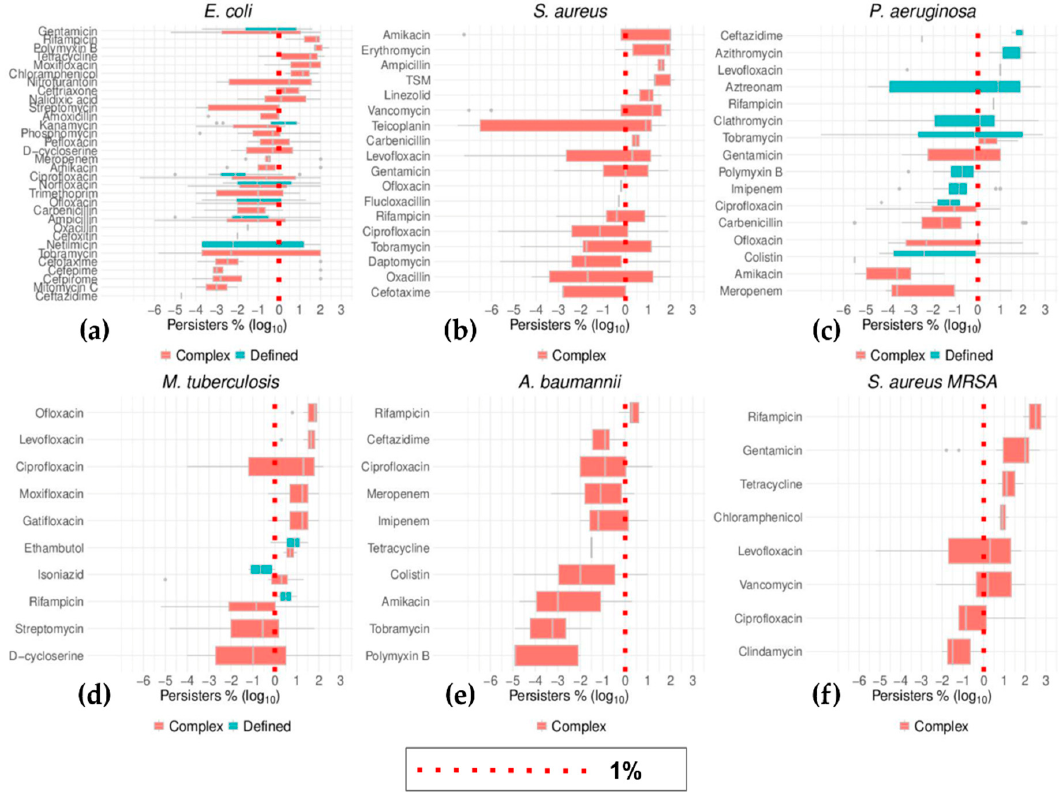
Figure 11. Distribution of the data grouped by media type in the six most studied bacteria species. The percentage (as log 10 ) of persisters to antibiotics as listed for each species were ordered by their median values. The media type of the cultures that underwent persistence tests were differentially plotted, red for samples from cultures in complex media and green for samples from cultures in defined media. The red dotted lines represent the position at which levels of persister cells of 1% are in each box plot. As elaborated in the main text, there were differences in the incidence of persisters between cells from either type of growth media. However, it is obvious that the data from either media are not equally represented, with defined media sparely used in only E. coli , P. aeruginosa , and M. tuberculosis .